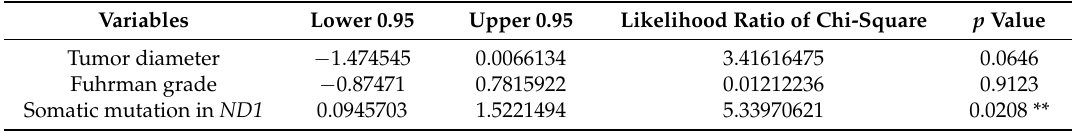
Table 7. Multivariate Cox proportional hazards regression analysis for factors associated with RFS after surgery of localized